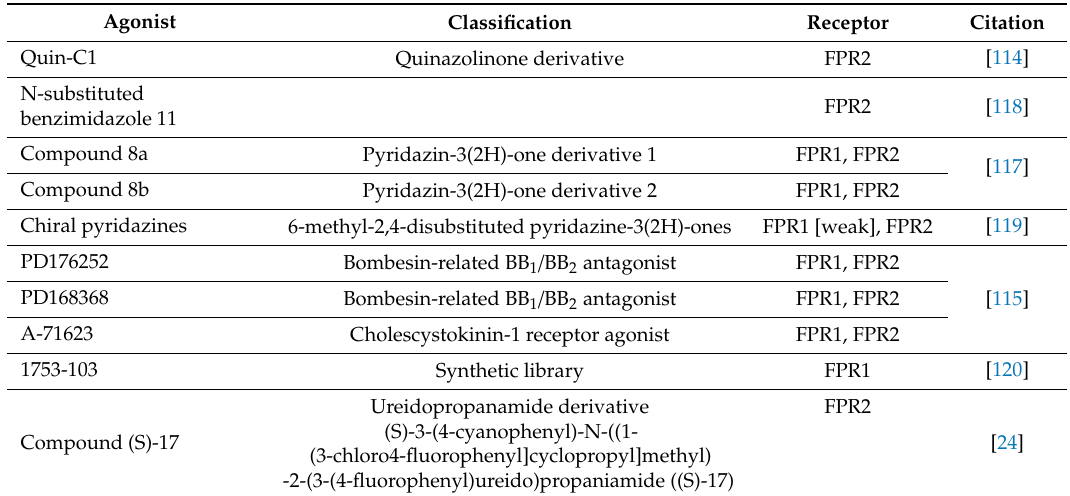
Table 6. Small / molecule compounds functioning as FPR (Fpr)